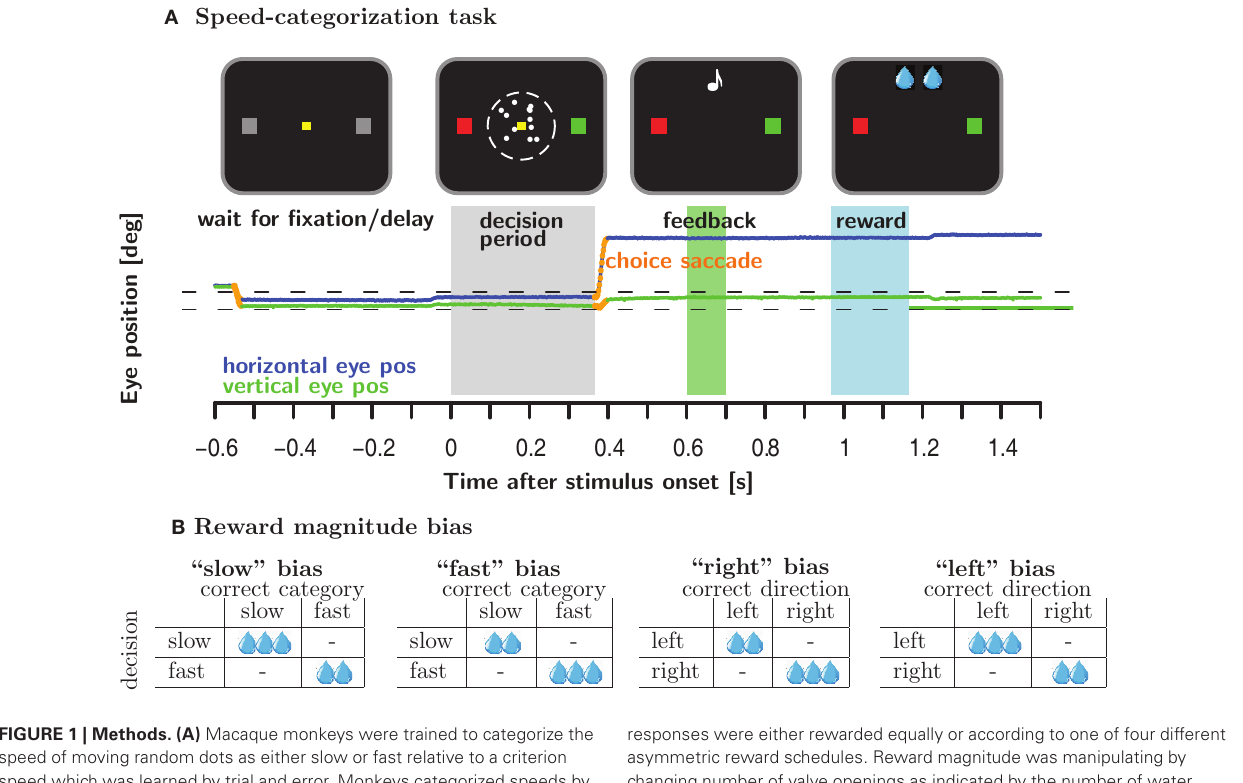
Figure 1 | Methods. (A) Macaque monkeys were trained to categorize the speed of moving random dots as either slow or fast relative to a criterion speed which was learned by trial and error. Monkeys categorized speeds by making a saccade to the red and green target to signal slow and fast speeds, respectively. (B) In the reward magnitude condition, correct